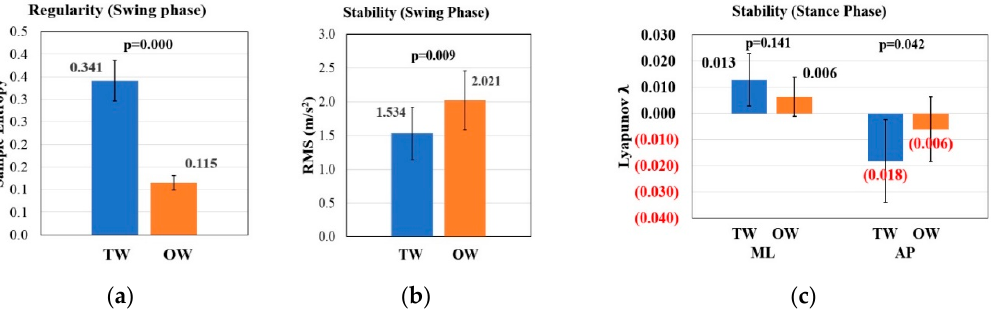
Figure 4. Comparison of gait features between TW and OW condition: ( a ) Sample entropy of foot acceleration during swing phase in V direction. ( b ) The RMS of foot acceleration during swing phase in V direction. ( c ) The maximal Lyapunov exponent of COP position during stance phase in ML and AP directions.